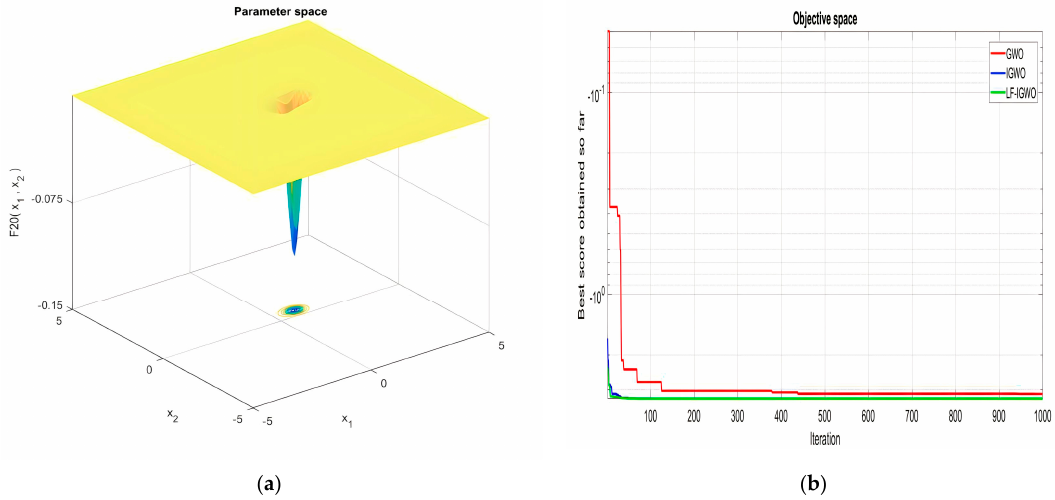
Figure 21. ( a ) Search space for fixed dimensional function F19 ( b ) Comparison of convergence curve for F19.